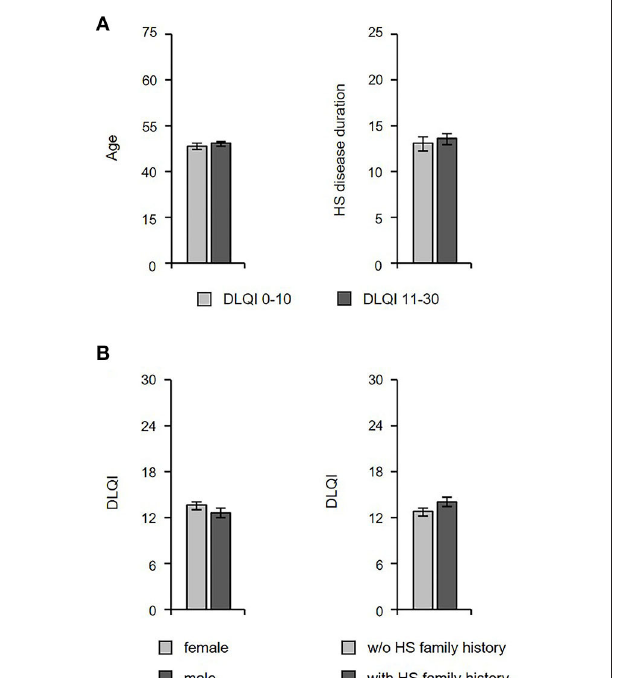
FIGURE 4 | Localization of skin lesions influences QoL. The frequency of HS patients ( n = 415) showing involvement of a specific localization of skin alterations and small/moderate (DLQI ≤ 10) vs. very/extremely large (DLQI > 10) QoL impairment are provided. The significance of differences was assessed using the Chi-square test (** P ≤ 0.01). DLQI, Dermatology Life Quality Index. 95.2 ± 2.0 vs. 101.2 ± 1.4; P = 0.023 / for men 100.3 ± 1.6 vs. 105.8 ± 2.2; P = 0.066) and a higher BMI ( Figure 6A )